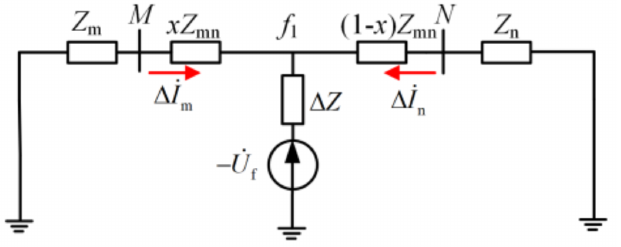
Figure 2. Positive–sequence fault component composite sequence network with